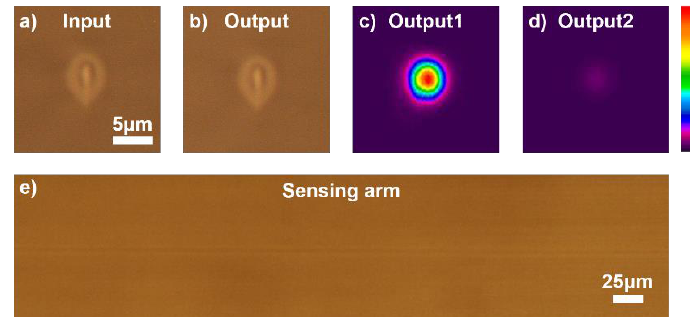
Figure 3. ( a , b ) Microscope photograph of femtosecond laser direct writing MZ interferometer input and output port. ( c , d ) Mode field photographs of the two output ports of the MZ interferometer without side polishing. ( e ) Microscope photograph of the sensing arm from the side view after side polishing.